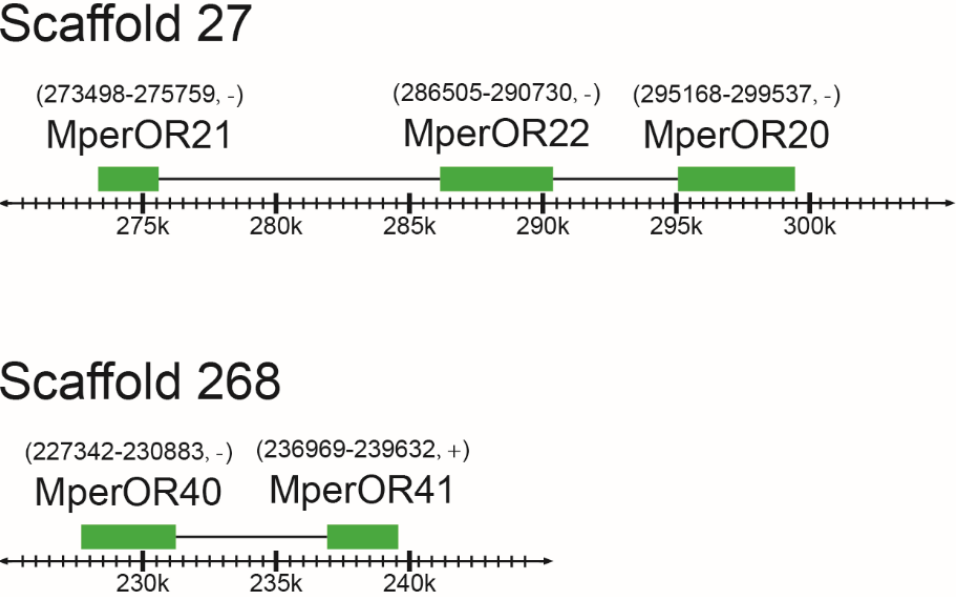
Figure 3. The tandem arrays of OR genes in M. persicae . The genomic sequences of M. persicae were downloaded from the AphidBase at the BioInformatics Platform for Agroecosystem Arthropods (https://bipaa.genouest.org/is/, accessed on 13rd May 2020)